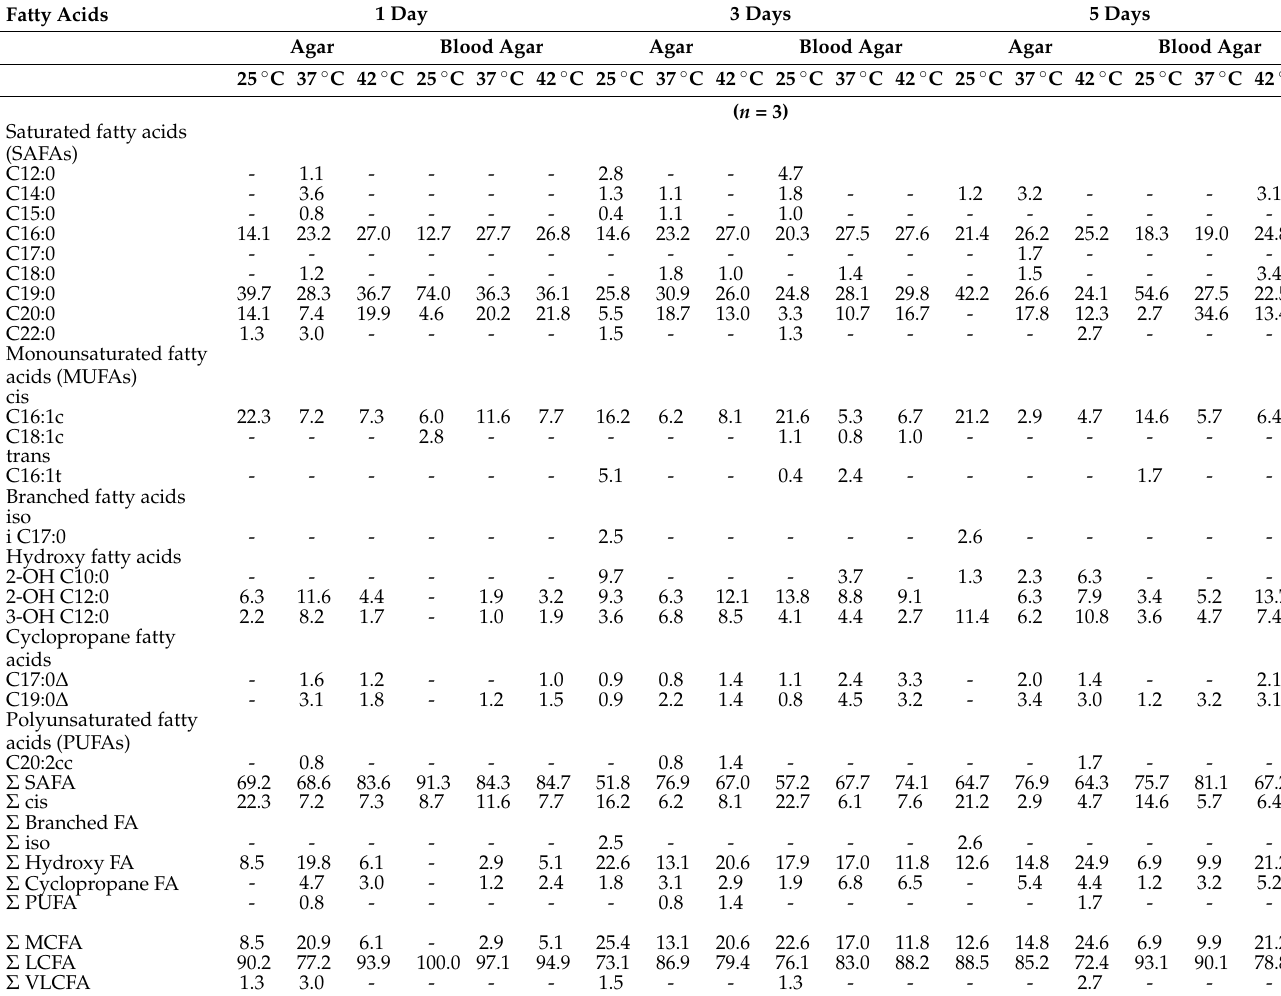
method was applied for analysis using the SLB-IL111 column for separation. The results obtained in the case of P. aeruginosa ATCC 27853 bacteria are shown in Table 5. Table 5. Fatty acid proportions (% of total fatty acids) of P. aeruginosa ATCC 27853 bacteria grown at 25 ◦ C, 37 ◦ C and 42 ◦ C using agar and blood agar media. The fatty acid extraction was made in triplicates from cultivates on the 1st, the 3rd or the 5th day following inoculation. The relative standard deviation is less than